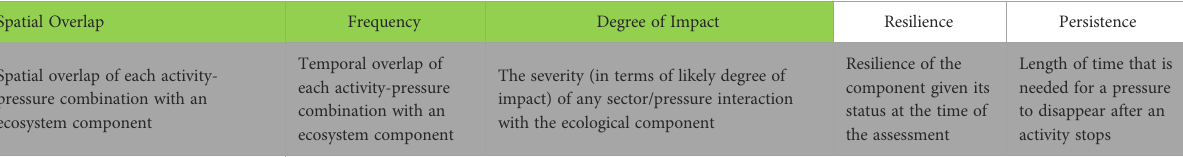
TABLE 1 Scoring categories, de fi nitions, criteria and numerical scores used in the assessment. De fi nitions for each category are provided under headings in grey boxes. Headings highlighted in green contribute to the Impact Risk score, those in white produce the Recovery Lag score. Note; the category ‘ Resilience: None ’ was not used in the